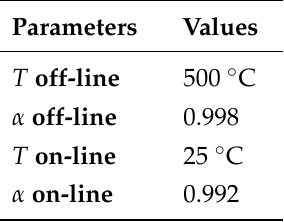
Table 2. The tuned SA algorithm parameters of off-line and on-line